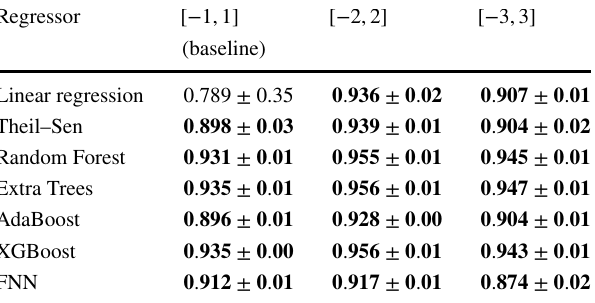
Table 3 Average of coefficient of determination R 2 (and its standard deviation) for different regression methods (with optimized hyperpa- rameter values), varying the interval of the temperature used to gener-